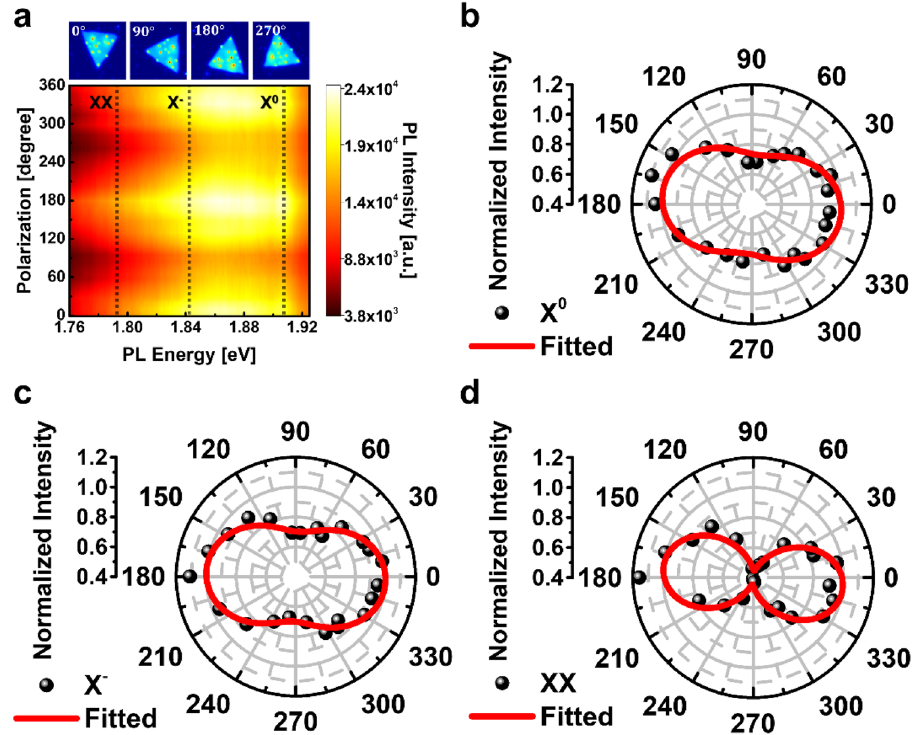
Figure 6. Polarization dependency of each exciton mode in the MoS 2 /AuNP hybrid. ( a ) Polarization- dependent hyperspectral PL image in the MoS 2 /AuNP hybrid. The normalized intensity of deconvoluted PL spectra depends on the excitation polarization for ( b ) the X 0 , ( c ) X – , and ( d ) XX